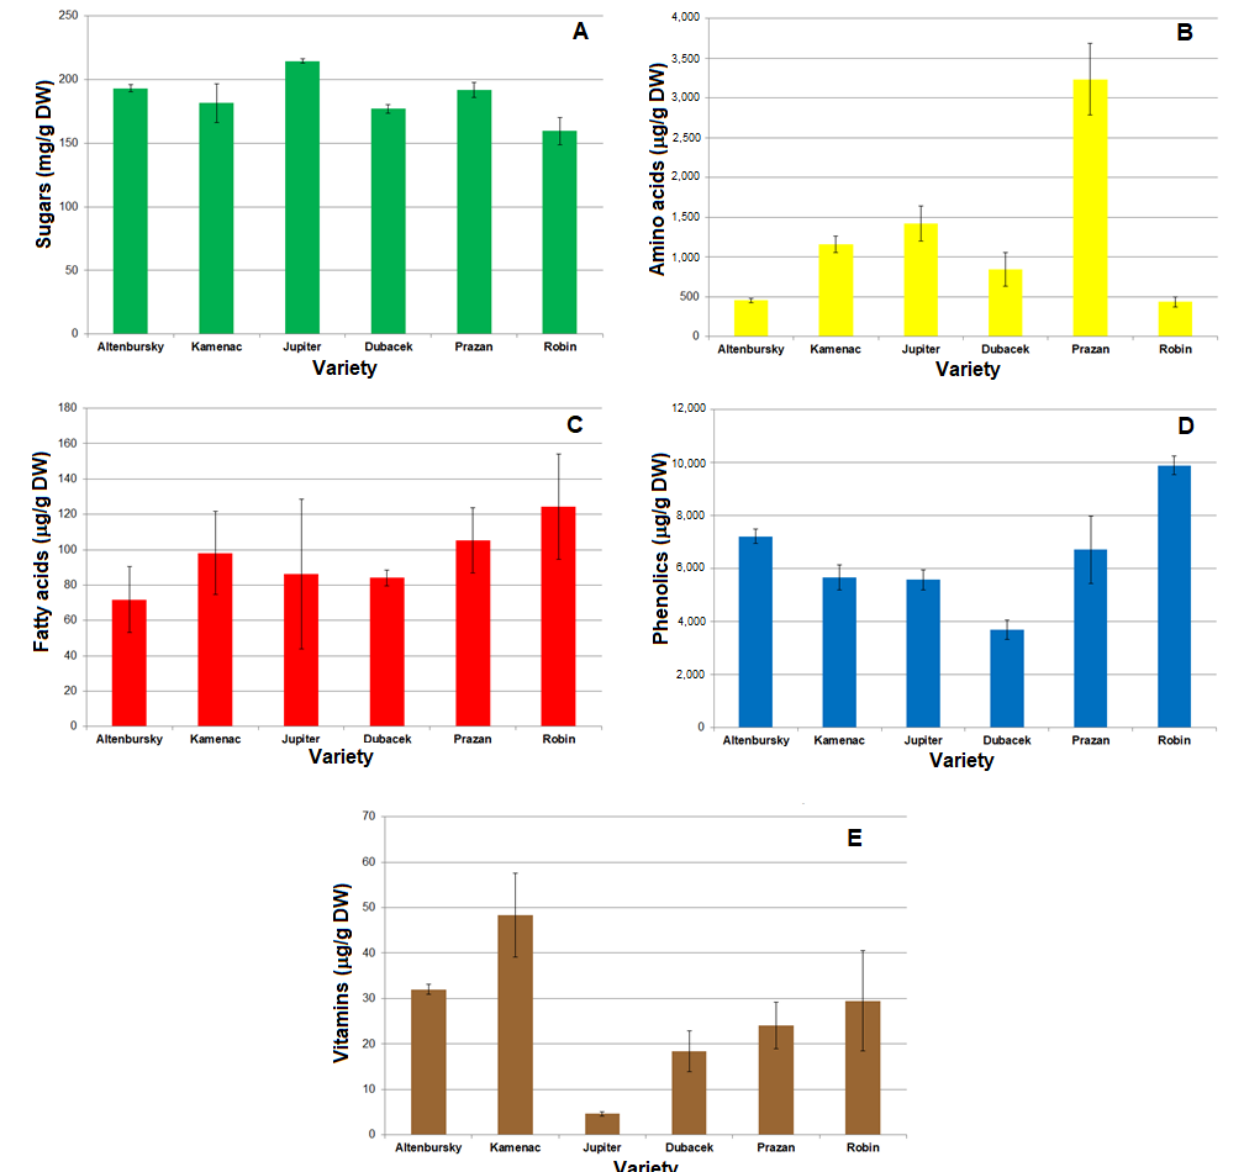
Figure 1. The total content of ( A ) free sugars, ( B ) free amino acids, ( C ) fatty acids, ( D ) free phenolics, and ( E ) vitamins in six lettuce varieties grown under control conditions. and ( E ) vitamins in six lettuce varieties grown under control